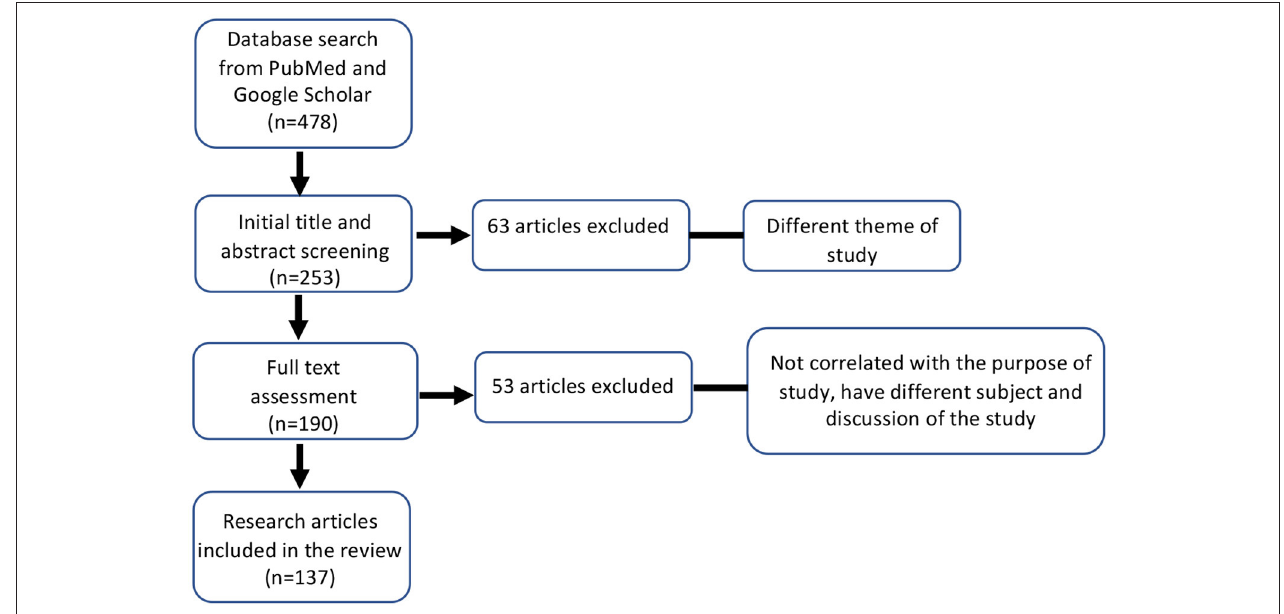
FIGURE 1 | Flow-chart of the literature search and inclusion/exclusion criteria used in this study. *** P ≤